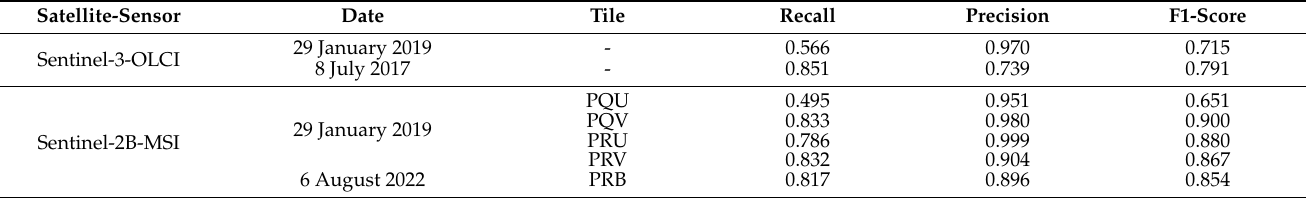
Table 5. Recall, Precision and F1-score from our models for some images of the focus dataset. Note that the results from 29 January 2019 images (MSI) are biased due to the use of their presence in the training